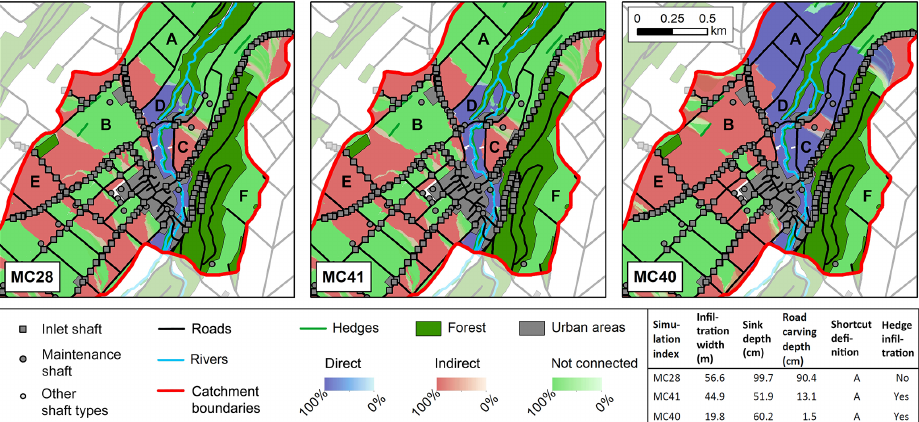
Figure 5. Results of three example Monte Carlo (MC) simulations for a part of one study area (Molondin). The colour ramps show the probability of agricultural areas to be directly connected (blue), indirectly connected (red), and not connected (green). The simulations represent, approximately, the 5% (MC28), 50% (MC41), and 95% (MC40) quantiles with respect to the resulting median fractions of indirectly connected per total connected area over all study catchments. The parameters of the example MC simulations are shown at the bottom right. Source of background map: Swisstopo (2010).